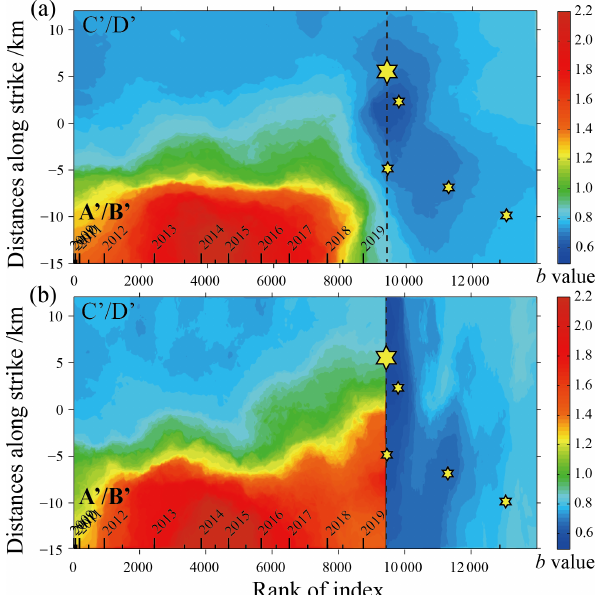
Figure 7. Spatiotemporal distribution of the median absolute devia- tion (MAD) of the b values of the best-100 solutions for N v = 2–40 in a 2-D space consisting of distance along strike and rank of in- dex. (a) The ensemble MAD b values obtained from all data before and after the Changning M S = 6 . 0 earthquake; (b) the ensemble MAD b values obtained from the data before and after the Changn- ing M S = 6 . 0 earthquake considered separately. The vertical dotted line shows where the M S = 6 . 0 earthquake occurred. The timescale is marked on the x axis (above the axis), including the time of whole years marked by long ticks and the half-year time marked by short